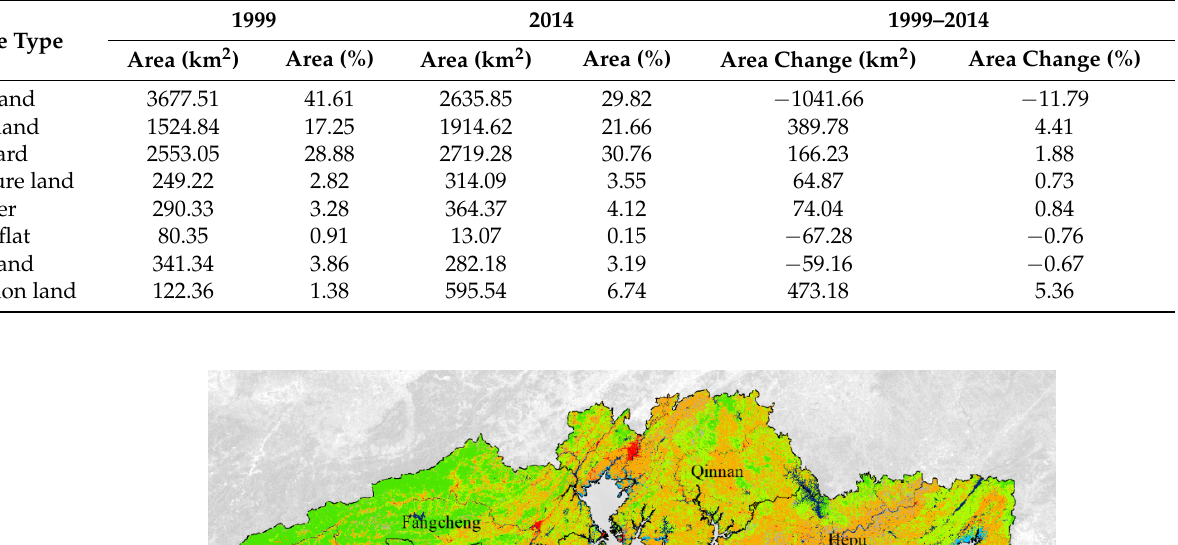
Table 5. Land use area and land use change from 1999 to 2014.